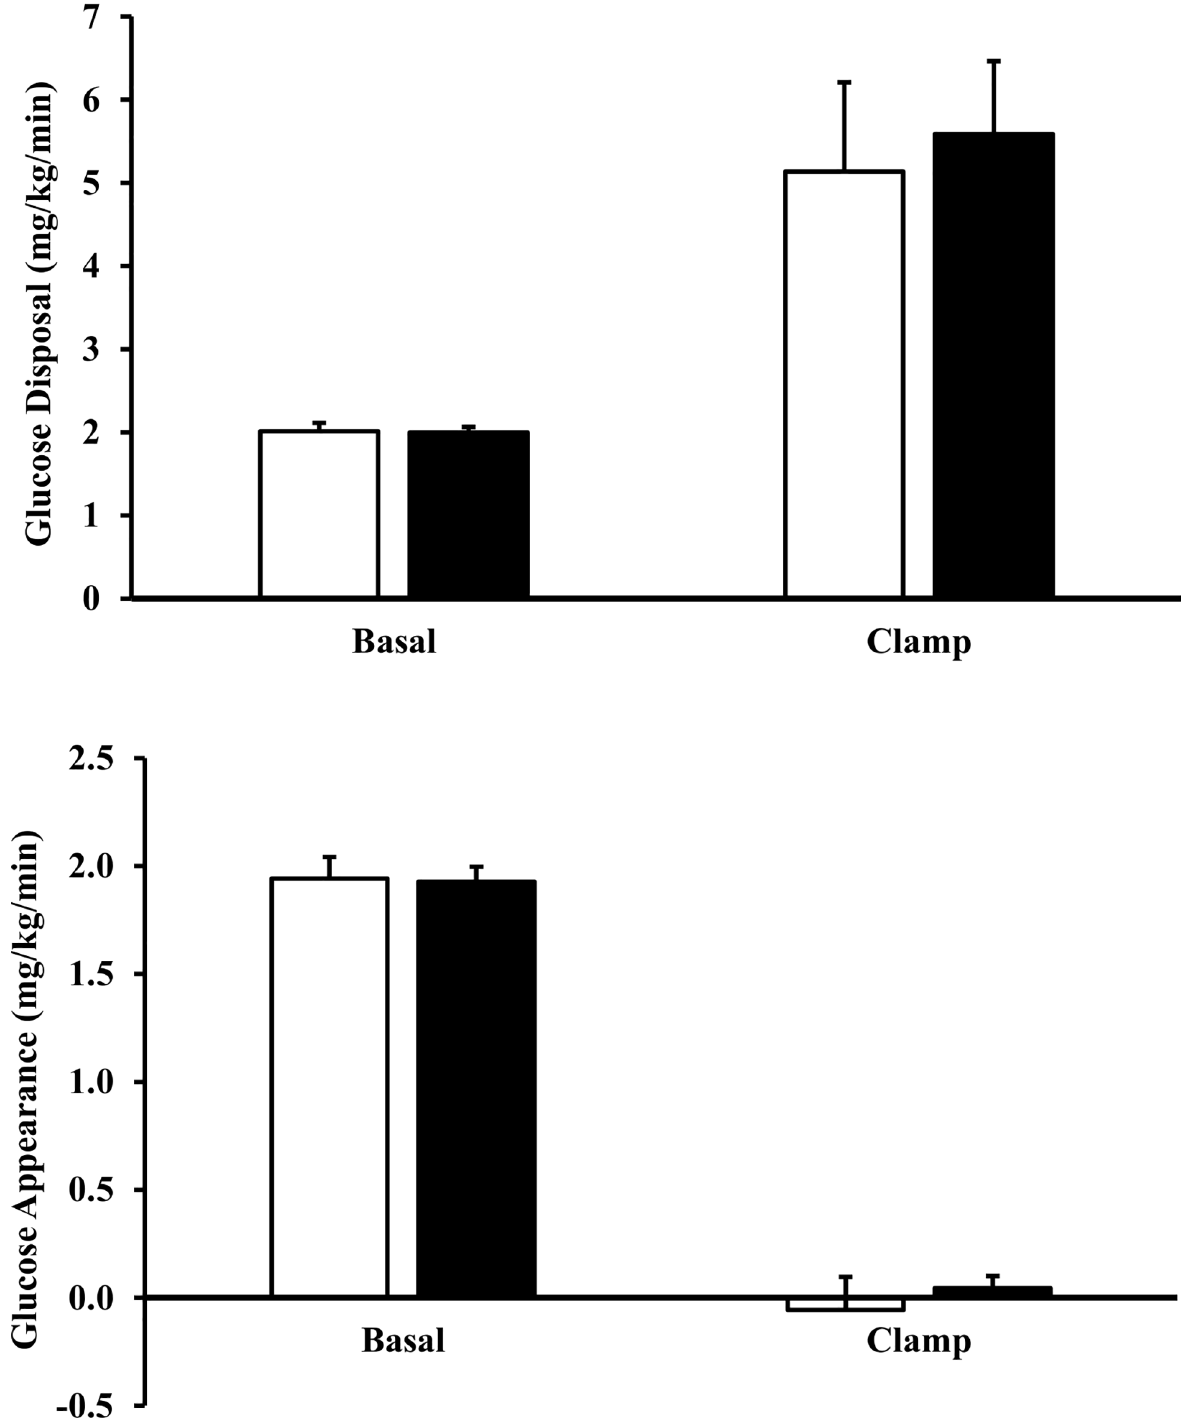
Fig 2. Glucose metabolism in the post-absorptive state and after two hours of insulin infusion in kidney transplant patients (n = 5) pre-transplant (open bars) and post-transplant (closed bars). Rates of basal and insulin-stimulated glucose disposal are given in panel A, and rates of basal and insulin-suppressed endogenous glucose production (B) were determined using 6,6 di- deuterated glucose. An 80 mU/(m 2 (cid:129) min) insulin infusion was used. Data are shown as means ± SEM.